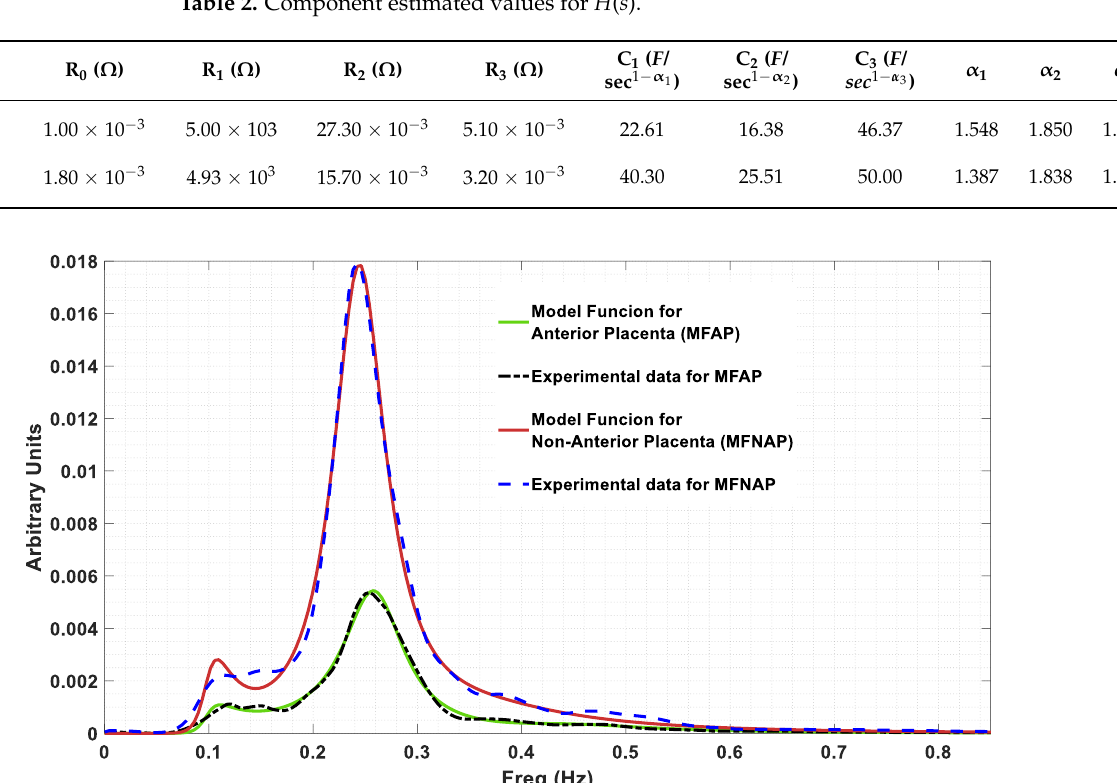
Figure 6. Poles of H ( s ) for the non-anterior placenta case (blue) and anterior placenta case (red), showing system stability. All poles are in the left half Argand plane. The time constants for the three Cole dispersion models are obtained by: 𝜏 𝑘 = (𝑅 𝑘 𝐶 𝑘 ) 1 𝛼 𝑘 ⁄ ; k = 1, 2, 3